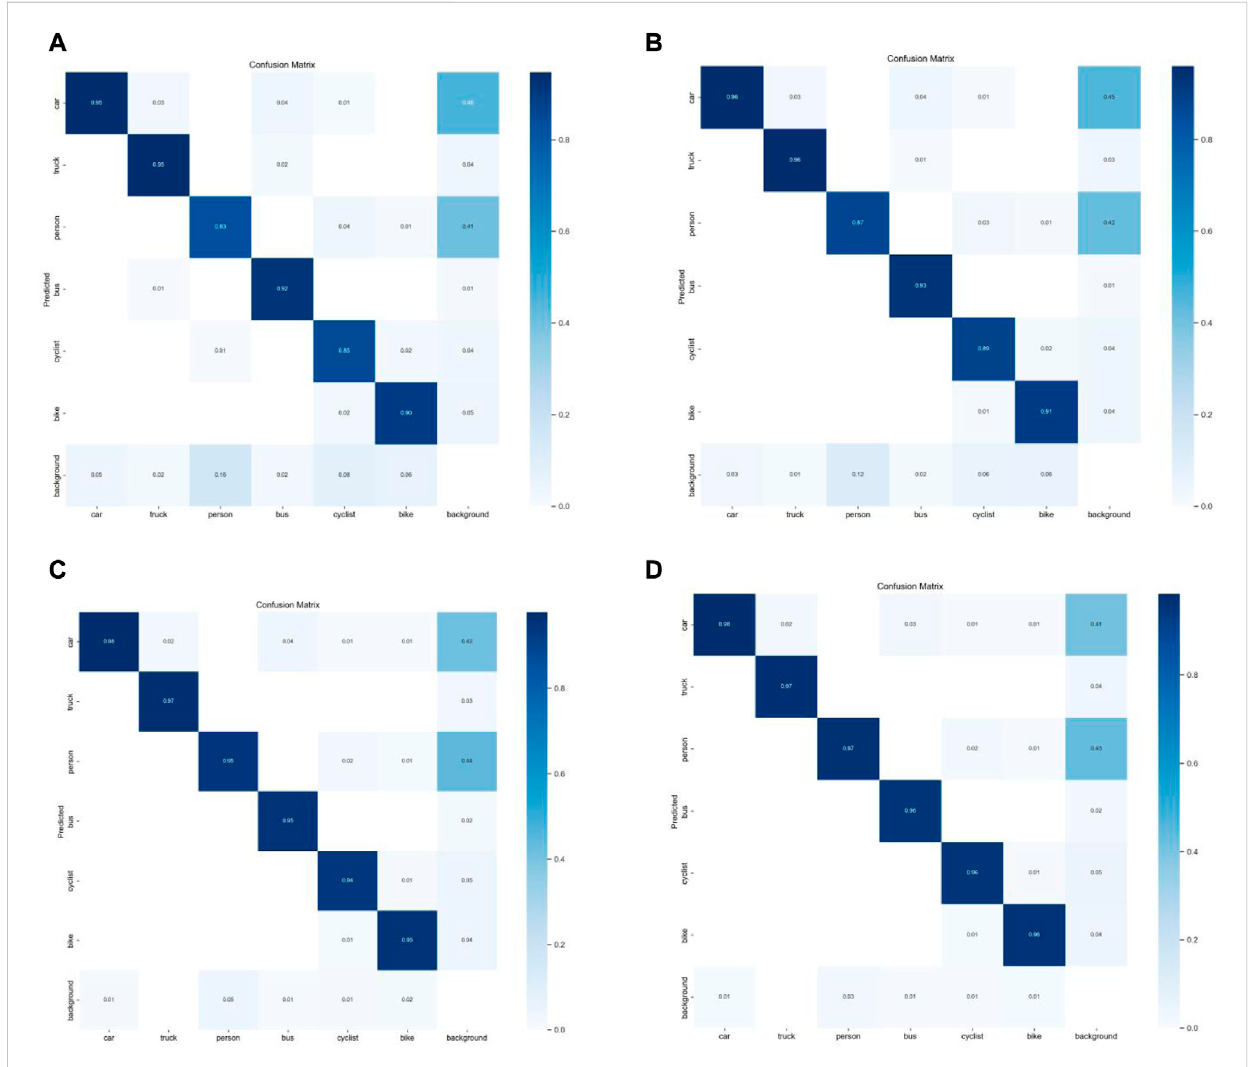
FIGURE 7 Confusion matrices. (A) YOLOv5s (B) YOLOv5s + Ghost (C) YOLOv5s + Ghost + GCA (D) YOLOv5s + Ghost + GCA + CPA.